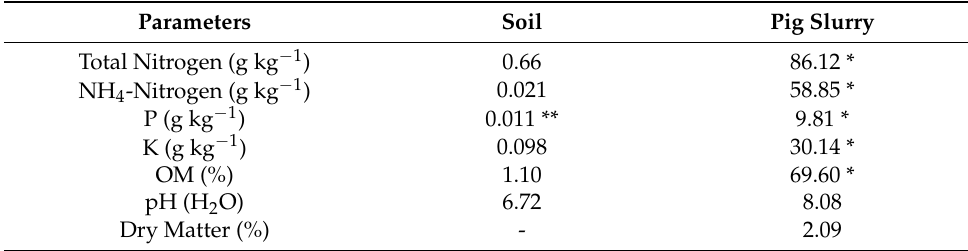
Table 2. Soil and pig slurry parameters (mean, n =